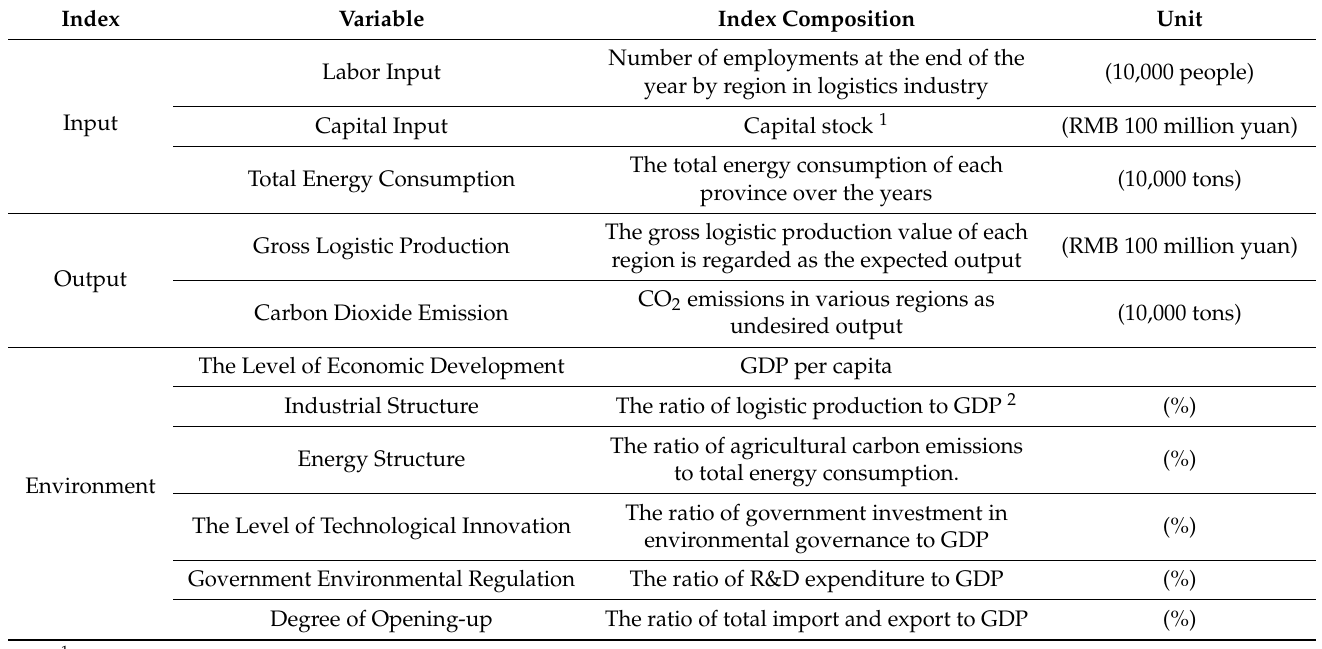
Table 2. Indicators for Measuring and Calculating the Dynamic